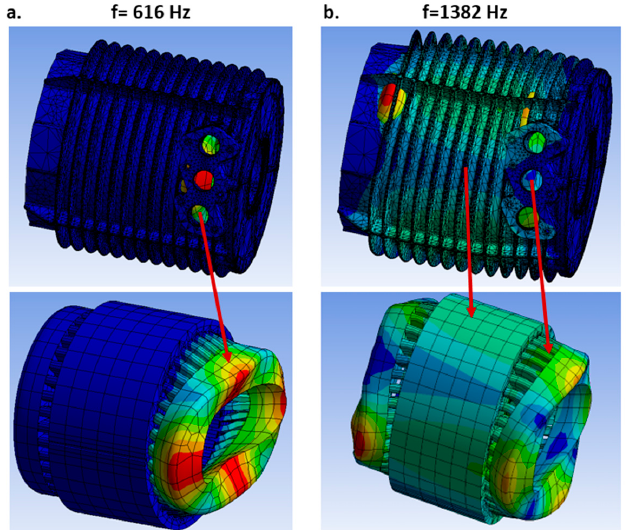
Figure 8. The calculated modal shapes of the IPM motor with the presence of the whole motor frame at the natural frequencies: ( a ) f = 616 Hz and ( b ) f = 1382 Hz. The stator frame in the lower figure is hidden in order to visualize the inner structure (i.e., the stator with windings).